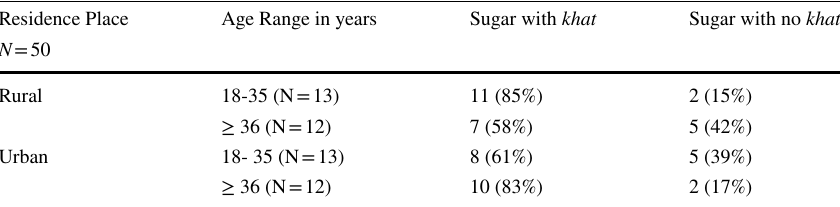
Table 4 Rural-Urban comparison of sugar use with khat between different age groups Residence